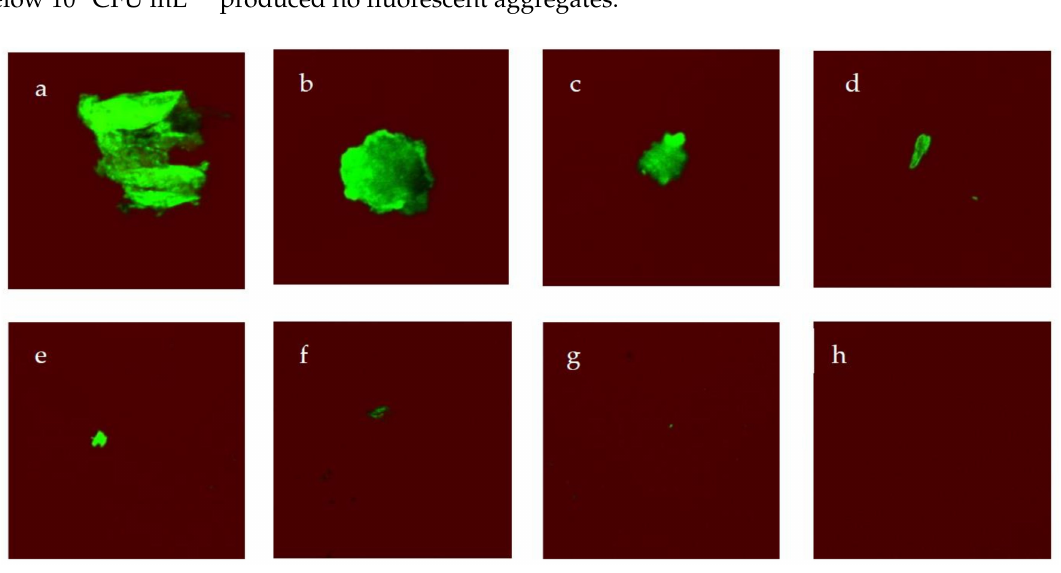
Figure 5. Confocal laser scanning microscopy images of E. coli (BL21) cells incubated with the mannose-coated polymer ( a ) 10 9 CFU mL − 1 ; ( b ) 10 8 CFU mL − 1 ; ( c ) 10 7 CFU mL − 1 ; ( d ) 10 6 CFU mL − 1 ; ( e ) 10 5 CFU mL − 1 ; ( f ) 10 4 CFU mL − 1 ; ( g ) 10 3 CFU mL − 1 ; and ( h ) 10 2 CFU mL − 1